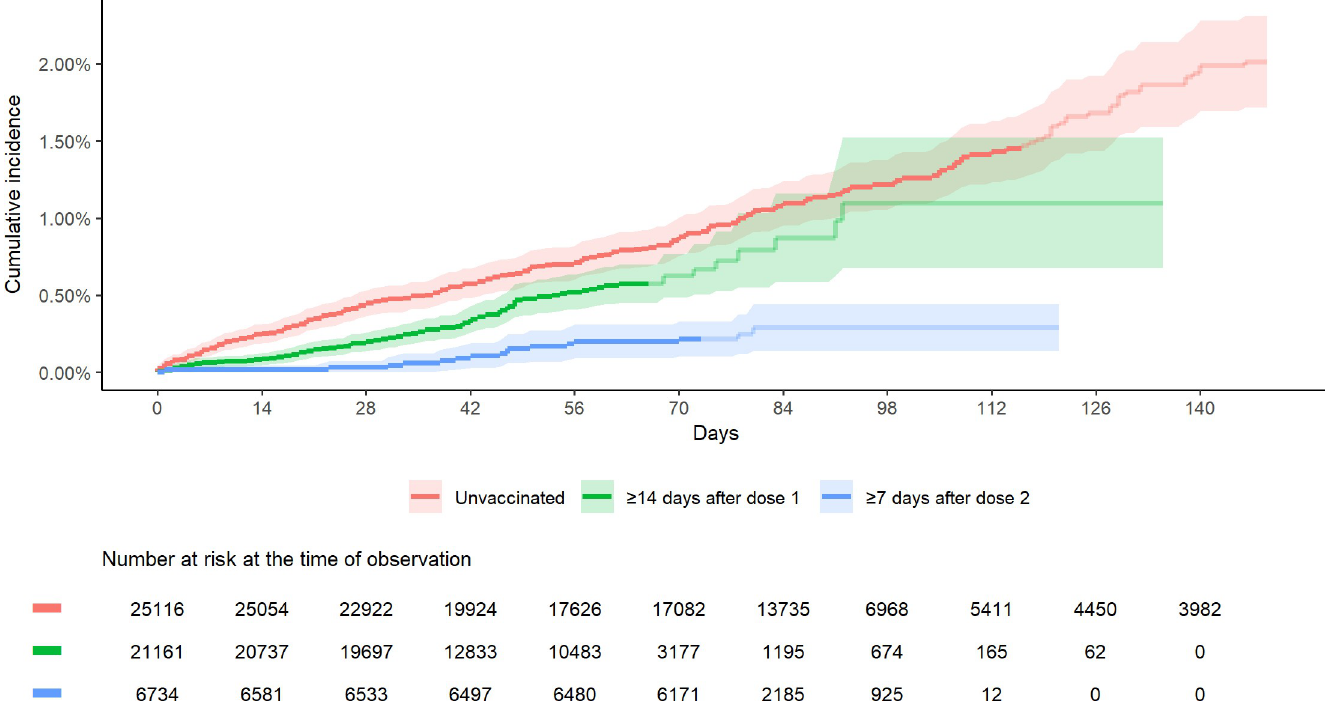
Fig 3. Cumulative incidence of COVID-19 infection comparing unvaccinated, partially vaccinated and fully vaccinated healthcare workers of Vancouver Coastal Health over time.